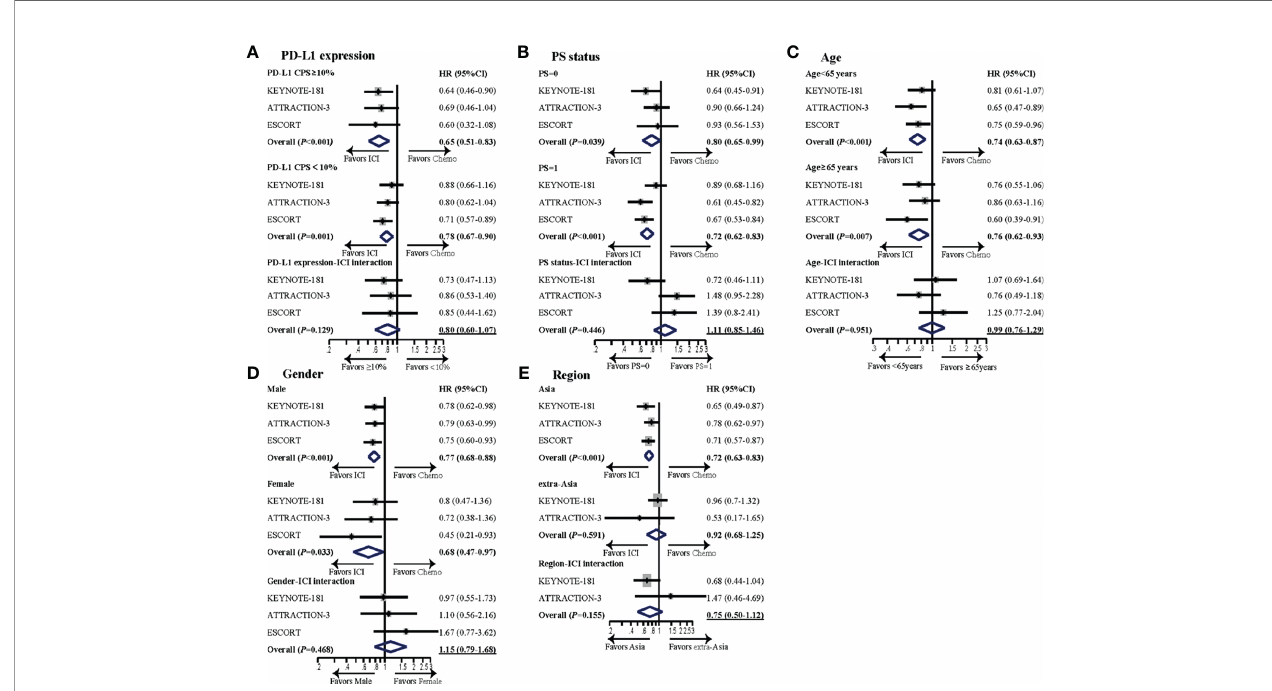
FIGURE 2 | Subgroup meta-analyses investigating survival bene fi t from PD-1 inhibitors in different subsets of patients. Subgroups analyzed included (A) PD-L1 expression, (B) PS status, (C) age, (D) gender, and (E) region. For each subgroup, forest plot of hazard ratio (HR) was performed for OS. The horizontal line crossing the dot represents the 95% con fi dence interval (CI). The dot represented the estimated overall effect, based on the analysis. In each study, subgroup-ICI interaction was calculated using the indirect analysis. Then, meta-analyses were performed for the pooled estimates with all the enrolled studies. The fi nal pooled results of subgroup-ICI interaction were shown by the data with underline. All statistical tests were two sided. PD-L1, programmed cell death ligand-1; CPS, combined positive score; HR, hazard ratio; ICI, immune checkpoint inhibitor; Chemo, chemotherapy; PS, performance